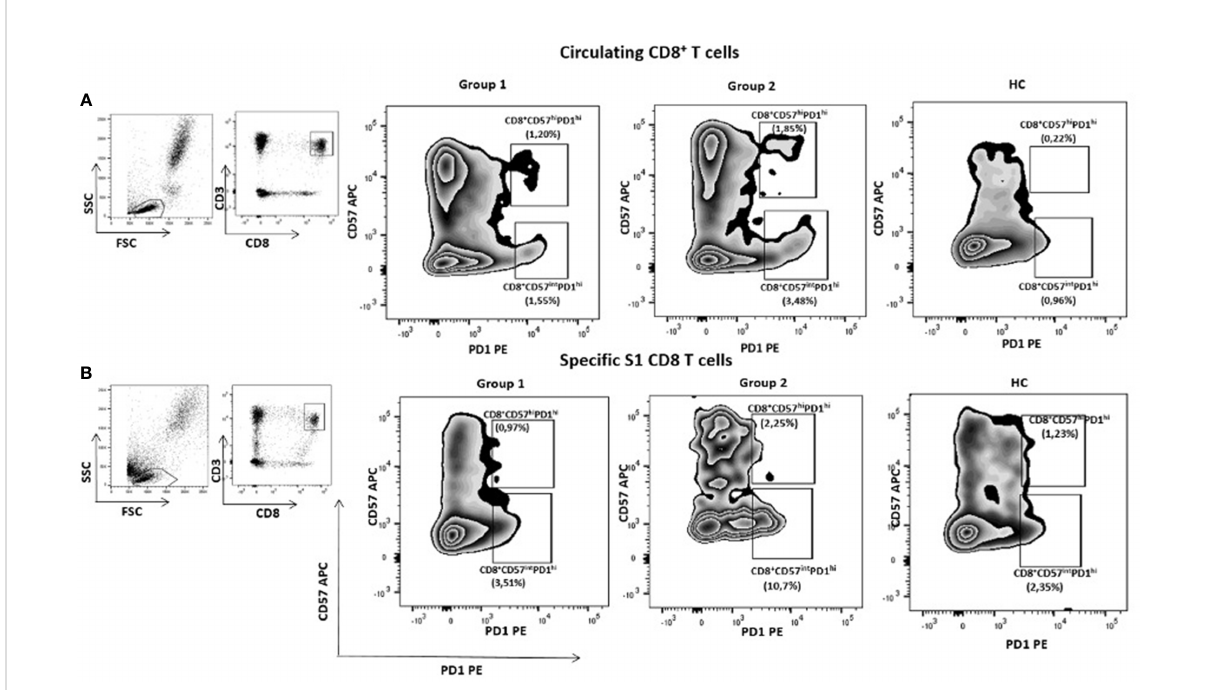
FIGURE 3 Exhausted CD8 + T cells according to the expression of PID and CD57 in an illustrative case of patients of each group of cancer patients and one healthy donor. All subjects have received three doses of mRNA vaccine. CD8+CD57hiPD1hi and CD8+CD57intPD1hi circulating T cells subsets were higher in group 2 compared with group 1. Similar results were seen in speci fi c S1 CD8+ T